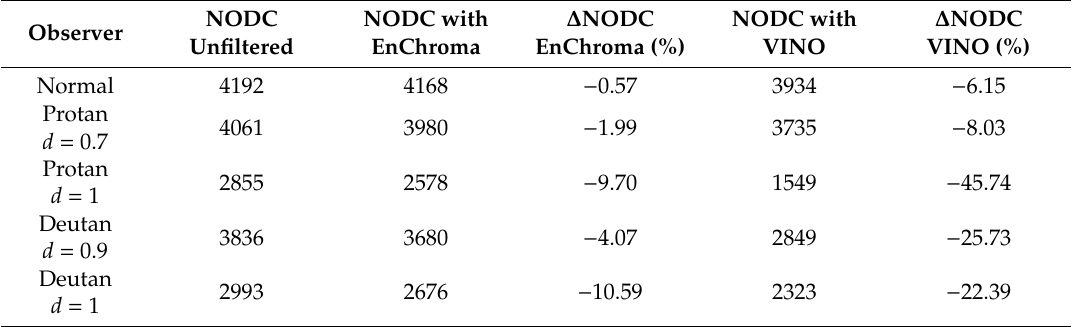
Table 3. NODC before and after filtering with the EnChroma and VINO filters, and the relative increase for dataset D1